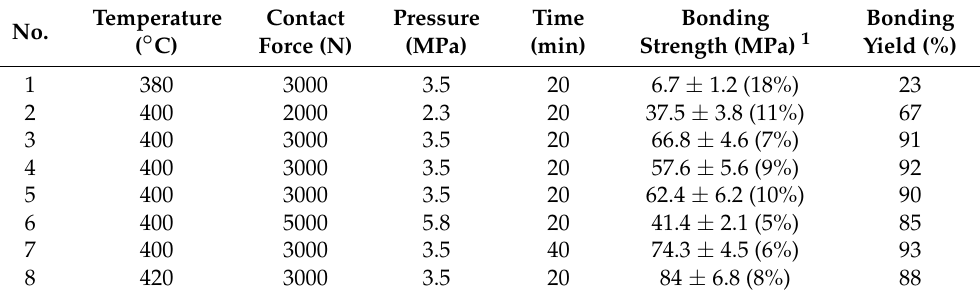
Table 1. Bonding quality of different parameters.